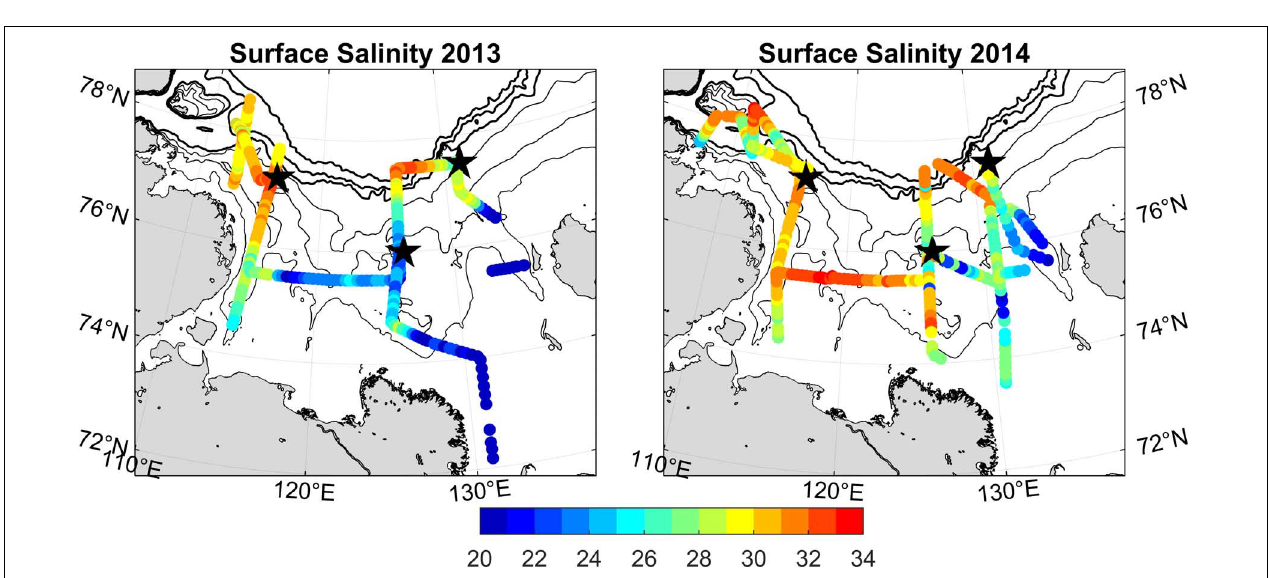
FIGURE 6 | Sea surface (0–10 m) salinity from the underway CTD surveys in 2013 (left) and 2014 (right) . The black stars indicate the mooring locations.